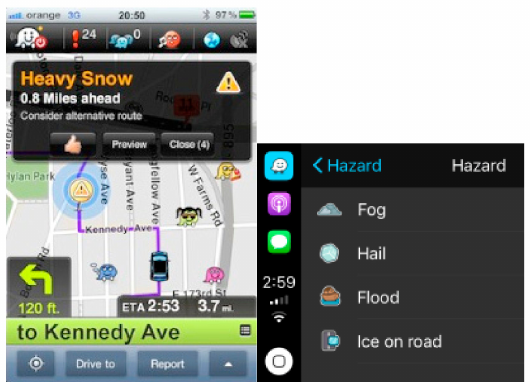
Figure 14. Waze users can report heavy snow hazards and other natural hazard events, such as flood events